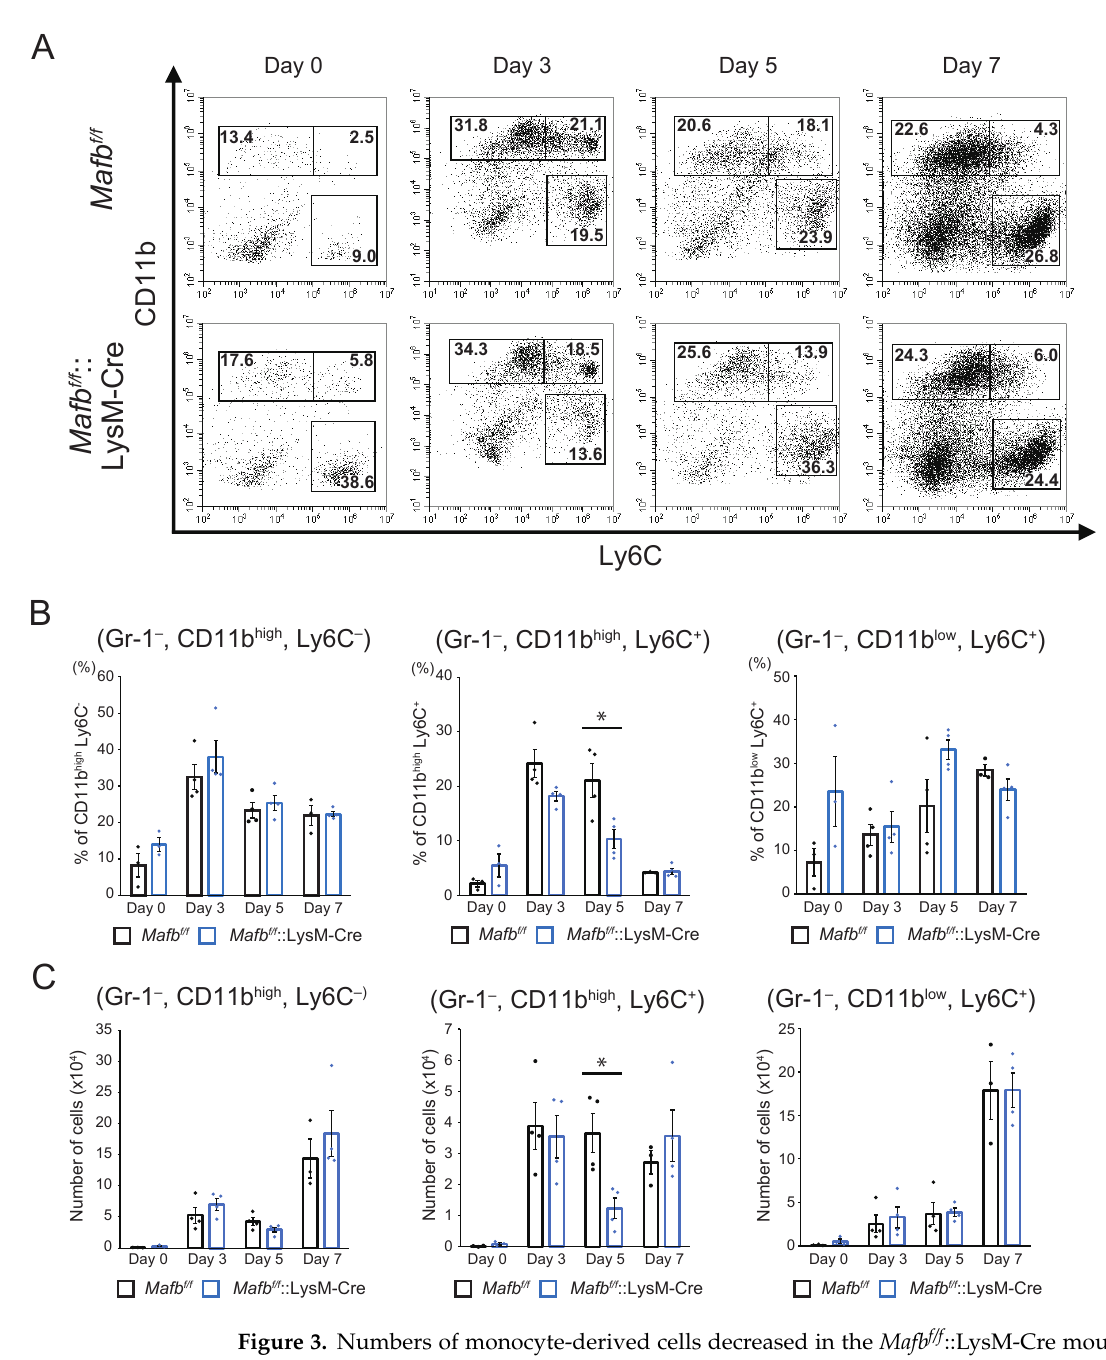
Figure 3. Numbers of monocyte-derived cells decreased in the Mafb f/f ::LysM-Cre mouse wounds. ( A ) Cells in the day 0, 3, 5, and 7 wounds were stained with anti-Gr-1, anti-CD11b, and anti-Ly6C antibodies and analyzed using flow cytometry. Dead cells and neutrophils were identified using DAPI, and CD11b and Gr-1 staining, respectively. Representative dot plots are shown for each day. ( B ) The % of each cell population in A per live Gr-1 − cells is shown. ( C ) The absolute numbers of cells in each population in A were calculated from the overall number of cells taken from the tissues and the % of each cell population. Data are means ± S.E.M; * p < 0.05, Student’s t -test. For each day, n = 3–4 for Mafb f/f and Mafb f/f ::LysM-Cre mice. Each dot represents data for a single